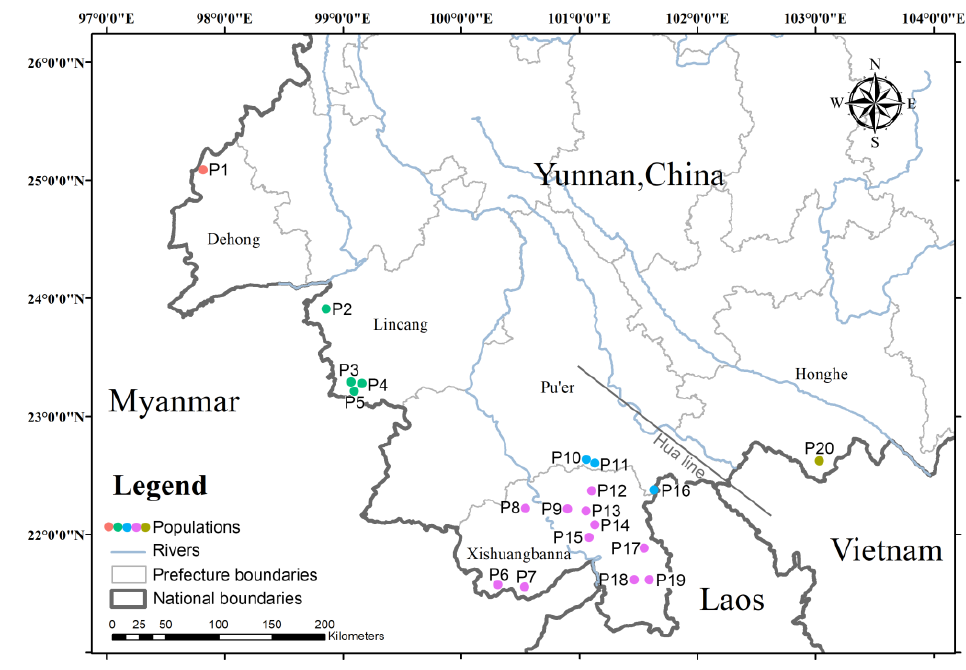
Figure 2. Distribution map of Eleutharrhena macrocarpa populations used for genetic diversity and structure analysis.